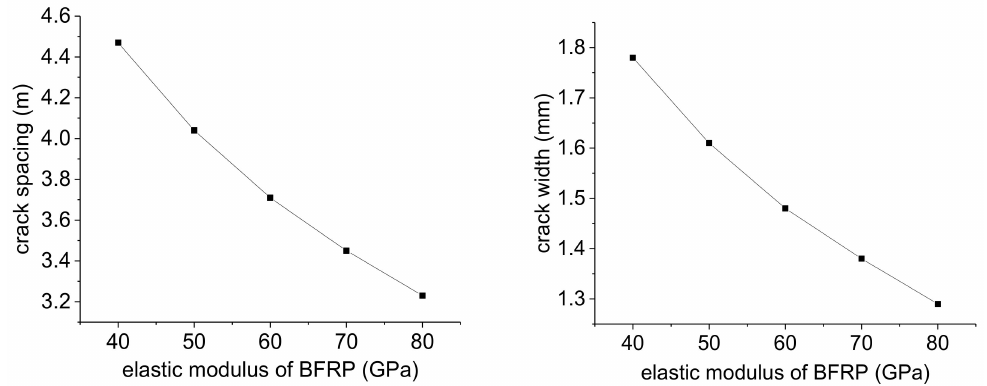
Figure 7. Impact of elastic modulus of BFRP on the crack spacing ( left ) and crack width ( right ) of CRCP with BFRP